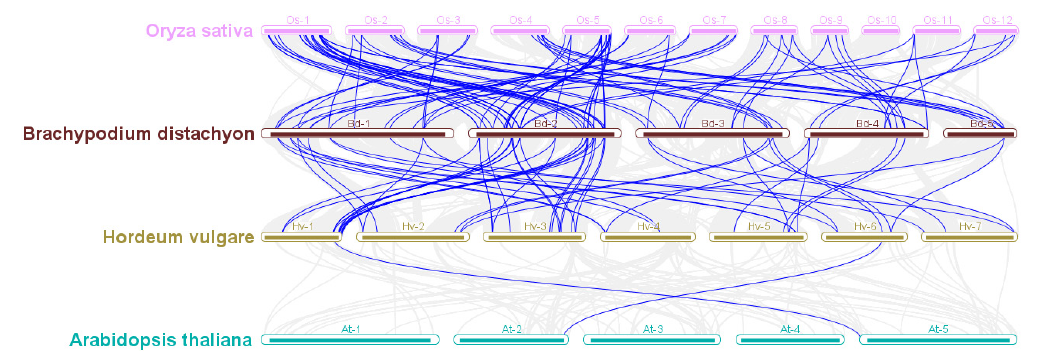
Figure 2. Collinearity analysis of WRKY genes in Oryza sativa L. (pink), Brachypodium distachyon (brown), Hordeum vulgare (grey), and Arabidopsis thaliana (blue). Each horizontal bar represents a chromosome. The orthologous WRKY genes were linked using blue curves.